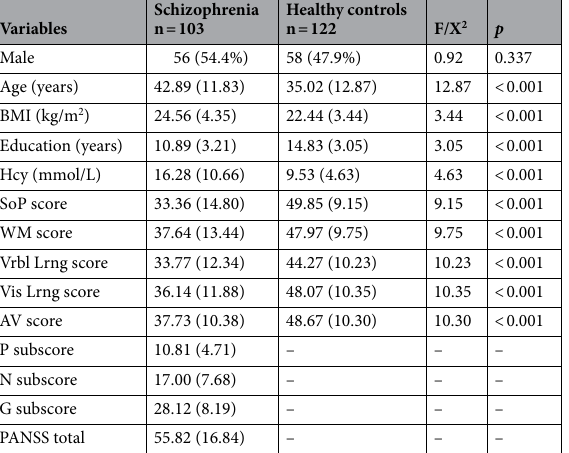
Table 1. Sociodemographic data and clinical profiles of patients with schizophrenia and healthy controls. Hcy homocysteine, SoP speed of processing, WM working memory, Vrbl Lrng verbal learning and memory, Vis